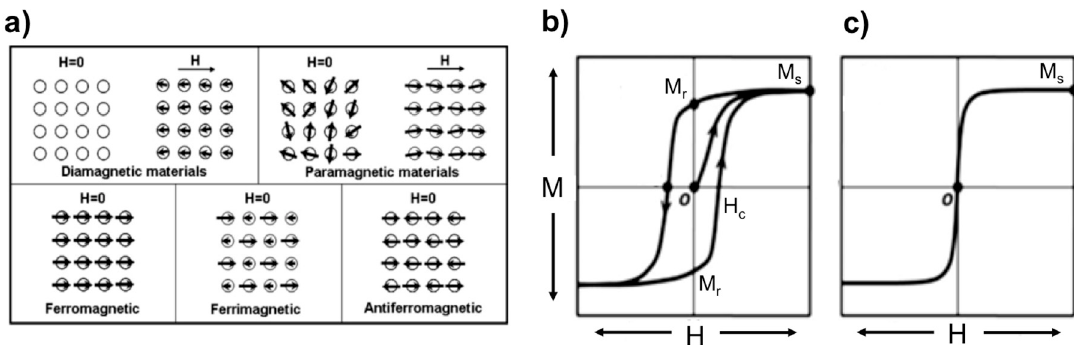
Figure 1. ( a ) Illustration of the behavior of the magnetic dipole moments in five types of magnetic materials with and without an external magnetic field (H). ( b ) Schematic of typical magnetization curves generated by an applied magnetic field. The general hysteresis loop shows the relationship of magnetization versus the applied magnetic field. The curved slope defines the magnetic susceptibility of the material. ( c ) A non-hysteretic magnetic curve of a superparamagnetic material. Reproduced with permission from [28], copyright 2007 Wiley, and from [8], copyright 2009 The Royal Society of Chemistry.